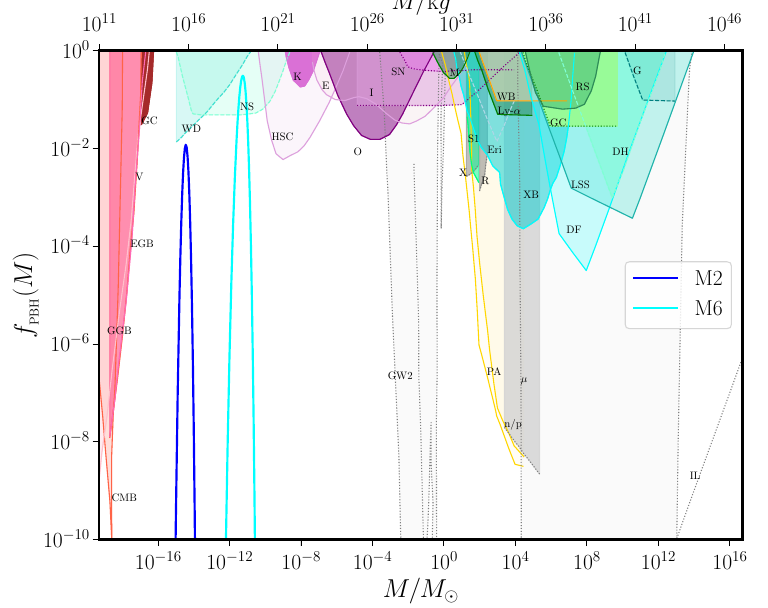
( M ) that constitute the cold dark matter density in the current Figure 7. The fraction of PBHs f PBH universe has been plotted for the inflationary models of interest. We had mentioned that the quantity ( M ) is very sensitive to the value of δ c . We find that, for the choice of δ c = 0.45, it is only the f PBH inflationary models M2 and M6 that lead to substantial formation of PBHs. In the figure, we have also included the constraints from the different observations, corresponding to a monochromatic spectrum of